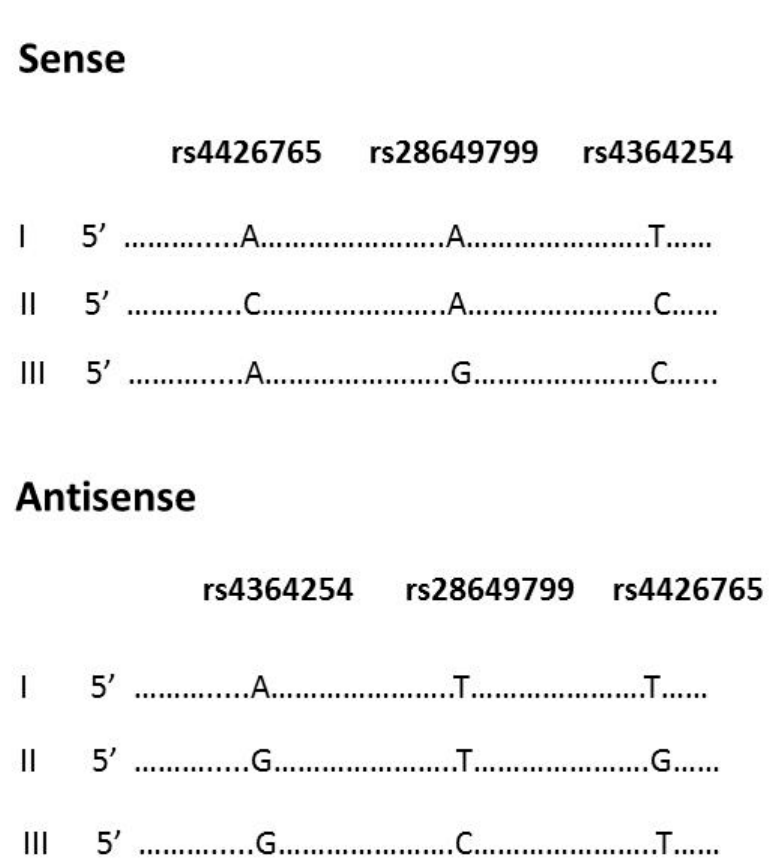
Figure 1. Structure of DNA constructs for luciferase reporter assay. Cloning of the HPSE gene fragment of intron 9 was performed using PCR II-TOPO vector. The insulator fragments were digested with Hind III and Xho I with subsequent ligation into phosphatase-treated pGL4.26 (luc2/minP/Hygro) vector. Three sense and three antisense DNA constructs were prepared. The constructs were designated with Roman numerals I, II, and III, and represent possible allelic variants in the general population.